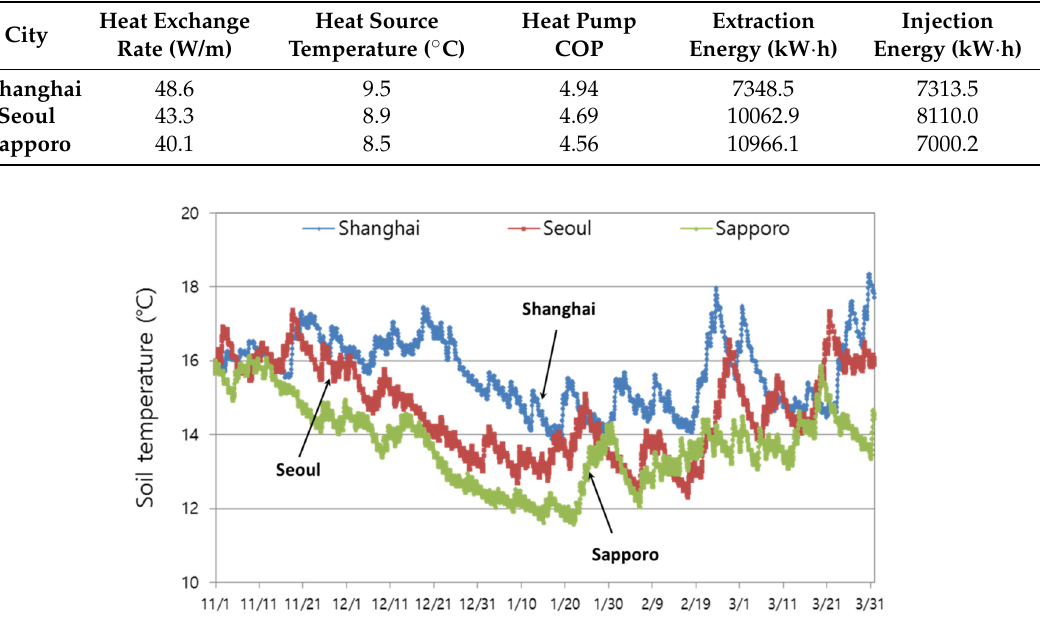
Table 6. Simulation results with different weather conditions.